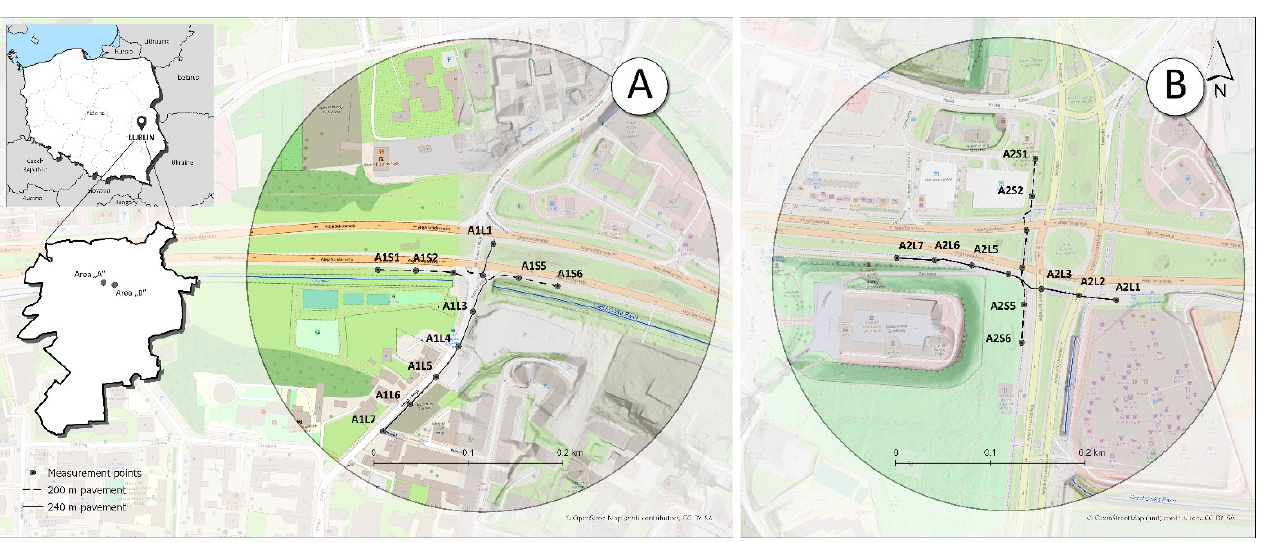
Figure 3. The case study areas and measurement points located along with pedestrian patches: ( A ) the area “A”, ( B ) the area “B”, distanced 1 km from each other.